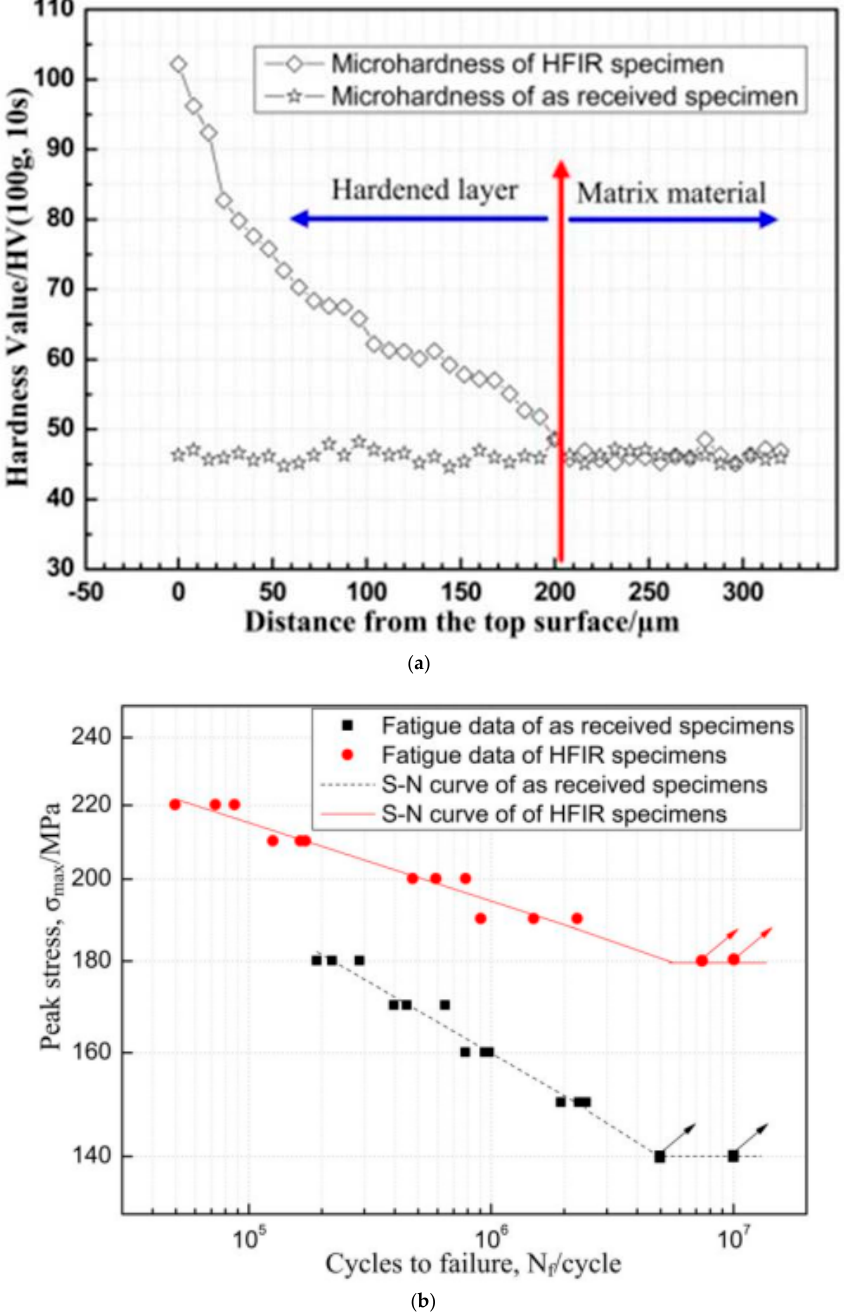
Figure 7. The impacts of HFIR on the material properties of AZ31 magnesium alloy “Reused with permission from Elsevier by License No. 5494620245825” [64]. ( a ) The cross-sectional microhardness of as-received and HFIR samples; ( b ) S-N curves of as-received and HFIR samples.